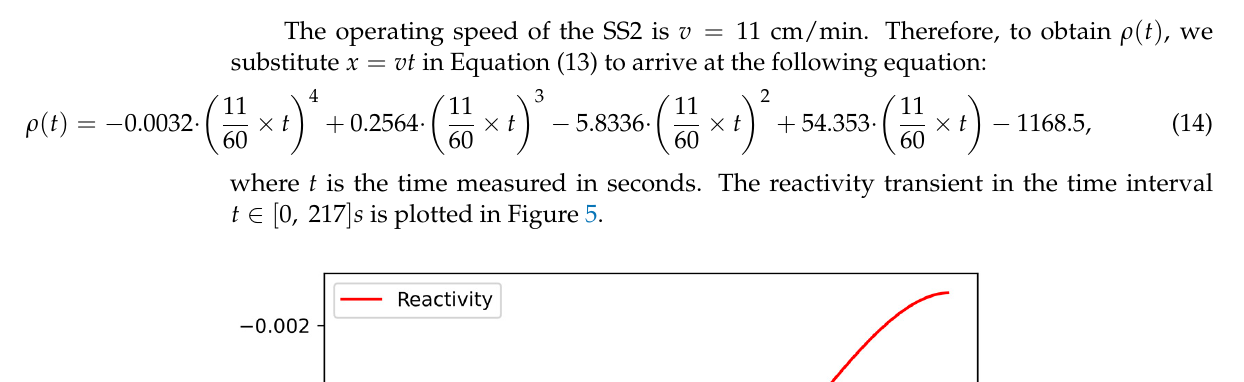
Figure 4. S curve of the SS2 control rod (cm) with respect to the reactivity (pcm) is depicted by the blue-colored line. Curve fitting of the obtained S curve is depicted by the orange-colored dotted line. The error bar due to uncertainty is depicted by the black-colored line.